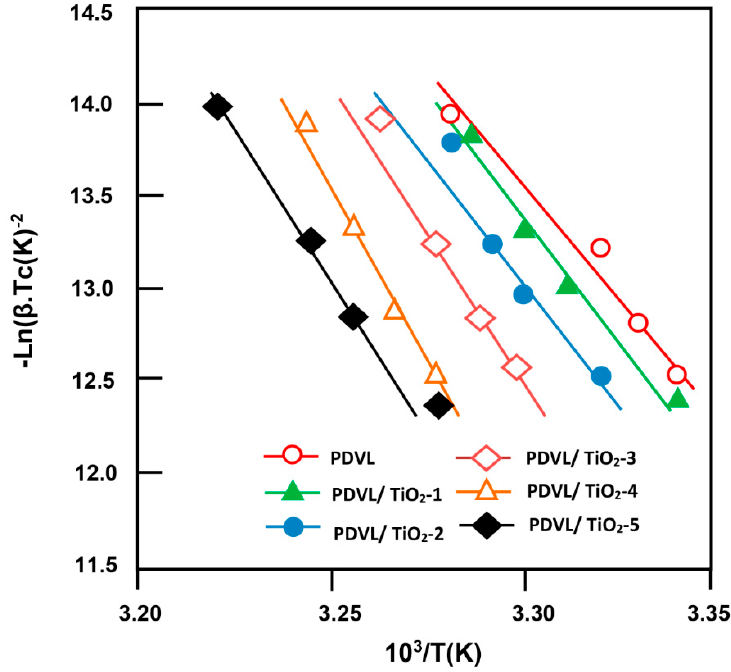
Figure 11. Kissinger plots indicating the variation of − Ln ( β · T c − 2 ) for pure PDVL and PDVL/TiO 2 nanocomposites at different compositions versus the reverse of temperature.